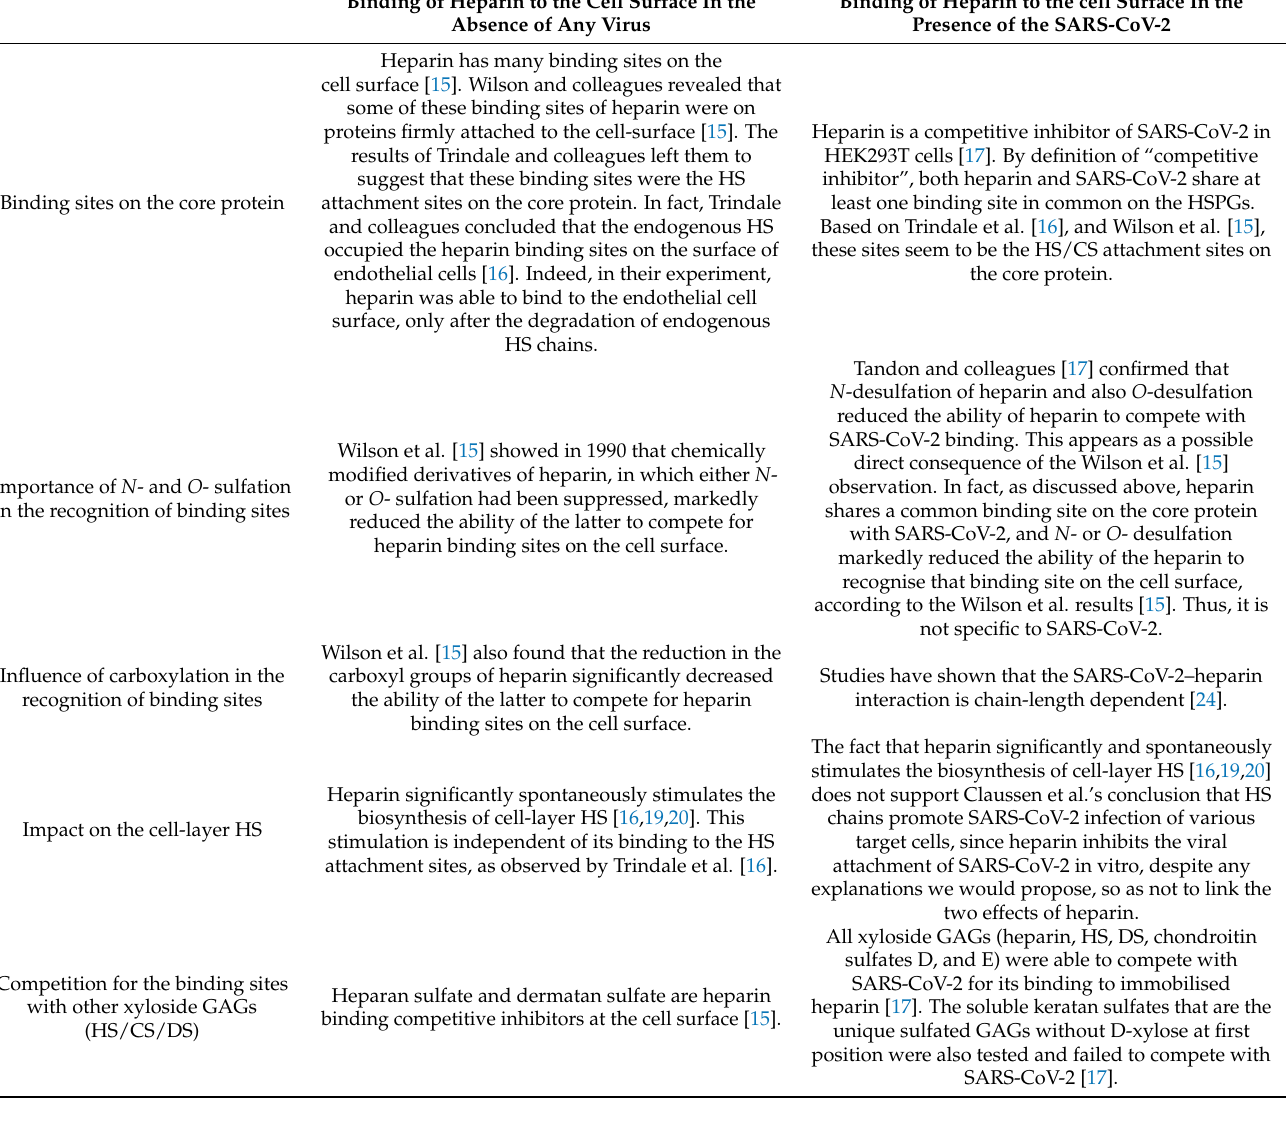
Table 1. Binding sites of heparin on the cell’s surface in the absence, and in the presence, of SARS-CoV-2. Situation 1 Situation 2 Binding of Heparin to the Cell Surface In the Binding of Heparin to the cell Surface In the Absence of Any Virus Presence of the